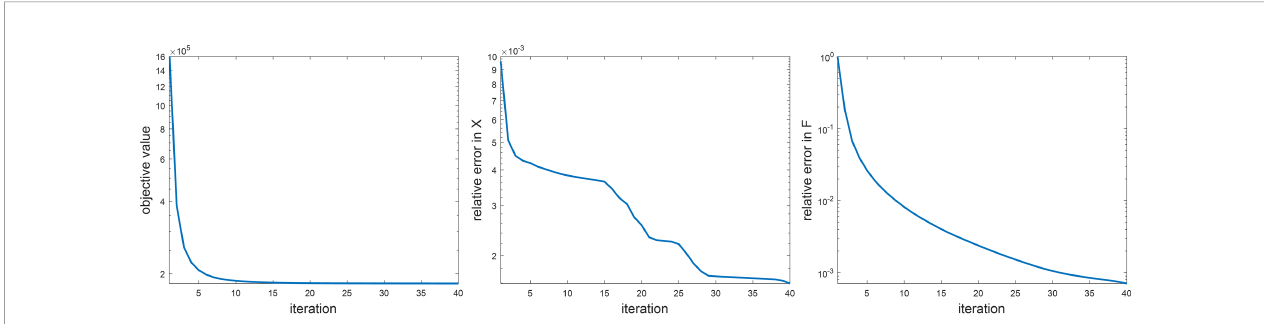
FIGURE 2 | Empirical analysis on algorithm convergence. Left: objective value, middle: || X ( k ) – X ( k – 1) || 2 /|| X ( k ) || 2 , right: F ( k ) – F ( k – 1) || 2 / F ( k ) || 2